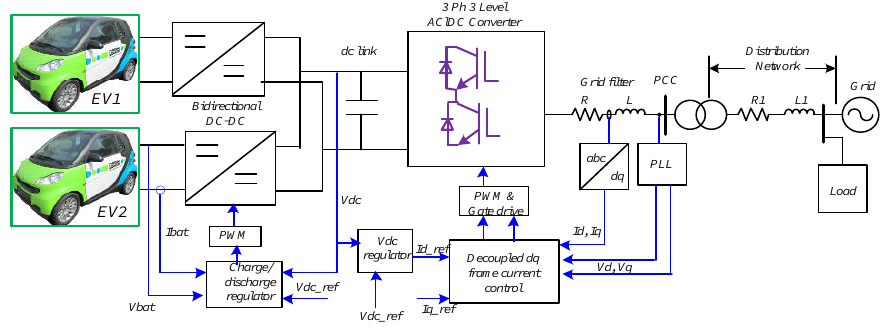
Figure 1. Configuration of grid-connected charging station. EV: Electrical vehicle; PCC: Common coupling point; PLL: Phase-locked loop; PWM: Pulse-Width Modulation.